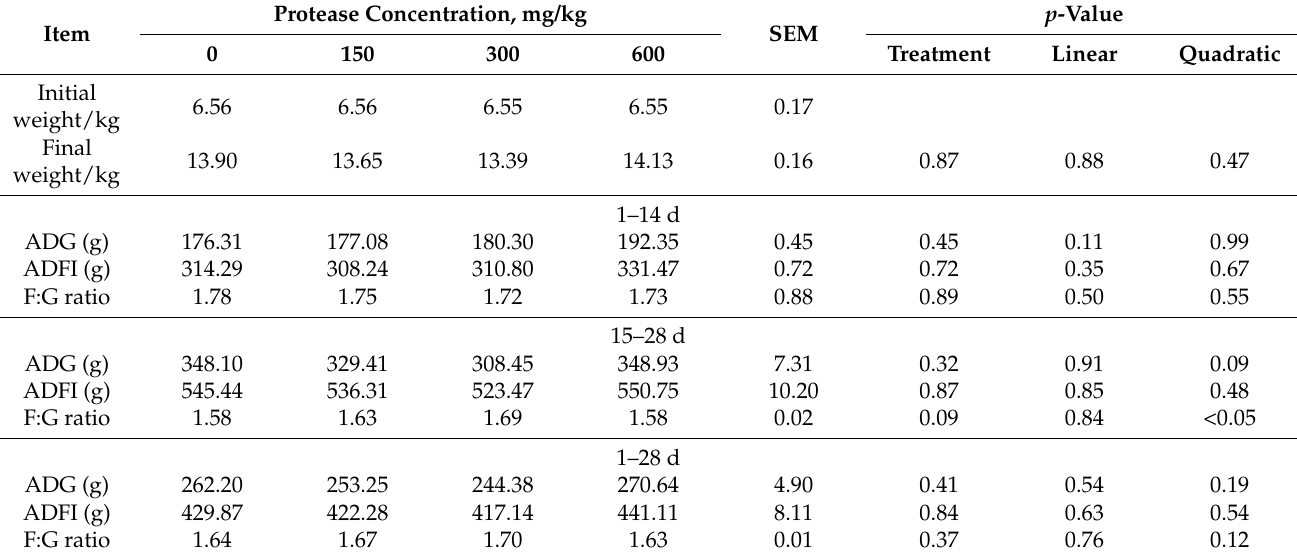
Table 3. Effects of protease supplementation on performance in weaned piglets.